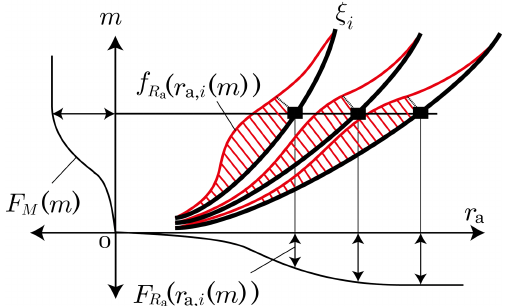
Figure 1. Relations between the non-exceedance probability of the annual maximum rainfall and that of the annual maximum eco- nomic damage (the curve bellow the horizontal axis is the CDF of the annual maximum rainfall F R ( r a ); the curve on the left of the a vertical axis is the CDF of the annual maximum economic dam- age F M ( m ); f R ( r a ) is the PDF of the annual maximum rainfall; a and red shaded areas correspond to the non-exceedance probability F M ( m